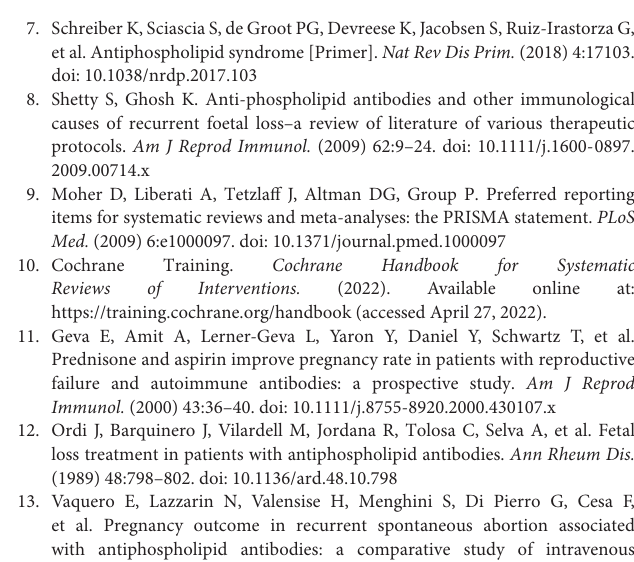
Supplementary Table 1 | Cohort studies excluded and reasons for exclusion. Supplementary Table 2 | Results of bias evaluation of RCT. Supplementary Table 3 | Results of bias evaluation of the retrospective cohort